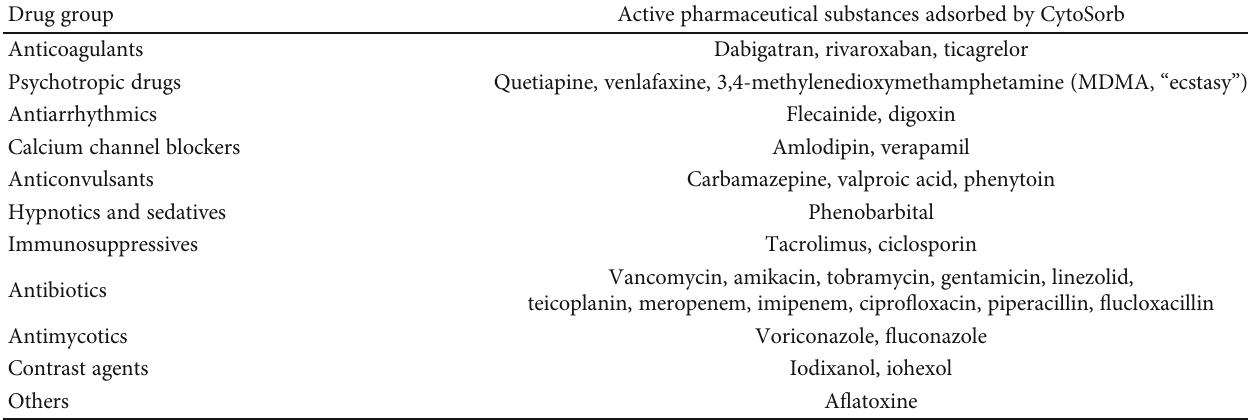
Table 1: Drugs for which an absolute or relative drug overdosage/intoxication can be treated with CytoSorb or a relevant decrease of serum concentrations must be expected (in modi fi cation of [16, 18 –